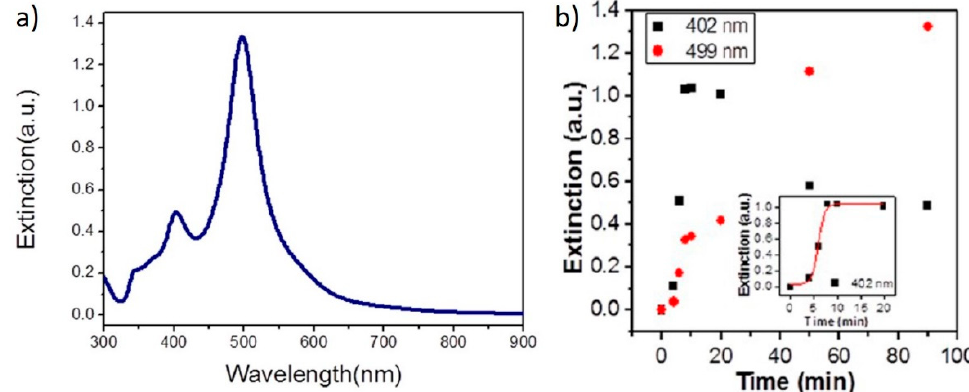
Figure 12. ( a ) optical absorption spectrum from Ag nanodecahedra produced by seedless photochemical growth; ( b ) time evolution of the SPR bands of Ag nanodecahedra during the growth reaction. Reprinted with permission from ref. [61]. Copyright 2012 American Chemical Society.